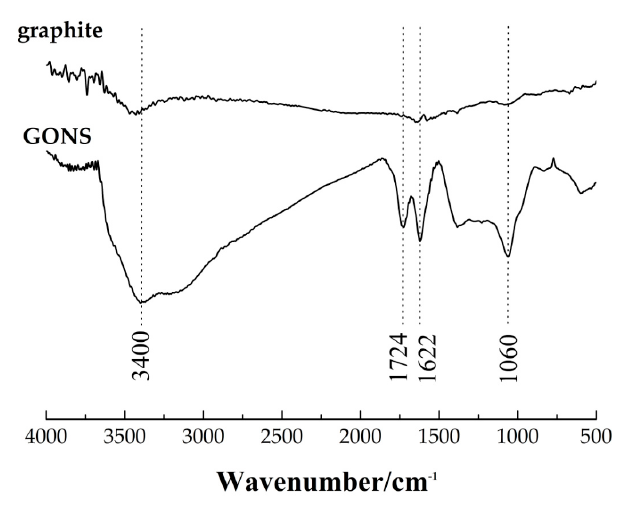
Figure 1. FTIR spectra of graphene oxide nanosheet (GONS) and graphite.